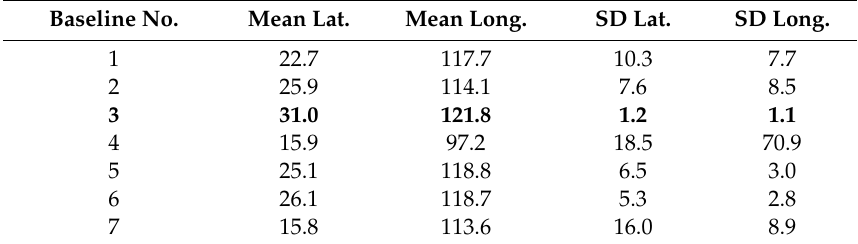
Table 6. Mean and SD values of outlier direction (latitude and longitude) estimates for all baselines (unit: